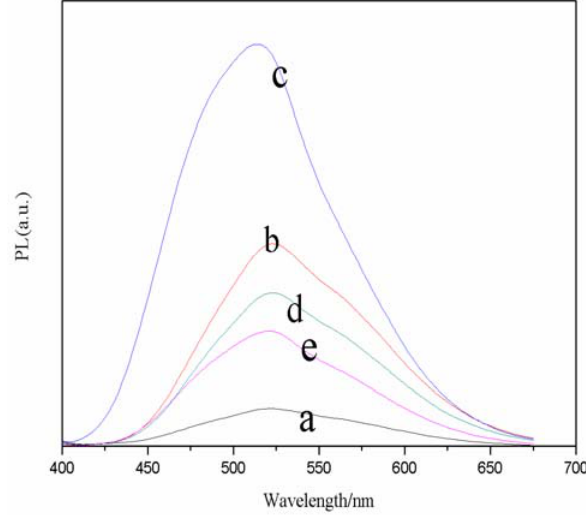
Figure 2. Effects of TGA/Se molar ratios on normalized FL spectra of TGA-capped CdSe QDs at freezing temperature. The reaction time was 30 min (a, 2.0; b, 2.1; c, 2.2; d, 2.3; e,